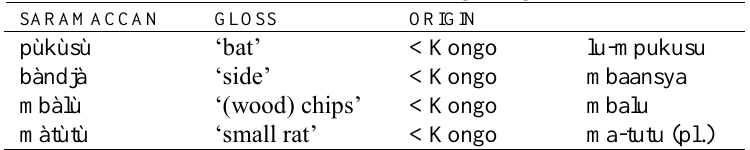
Table II: Some Saramaccan words of Kongo